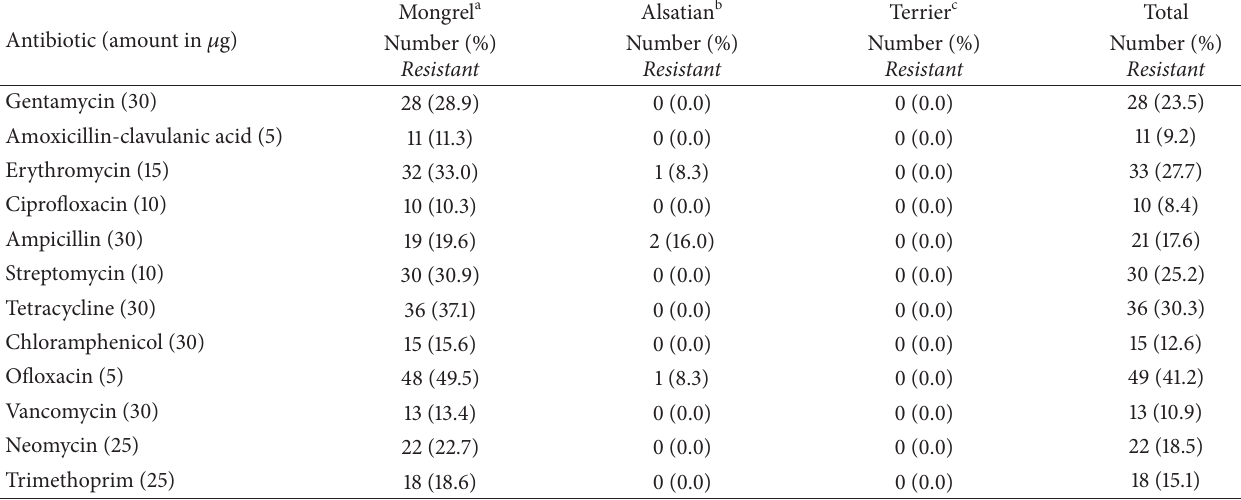
Table 3: Antibiotic susceptibility pattern of Salmonella isolates from exotic and local breeds of dogs in Maiduguri, Nigeria ( 𝑛 = 119 ). Mongrel Antibiotic (amount in 𝜇 g)